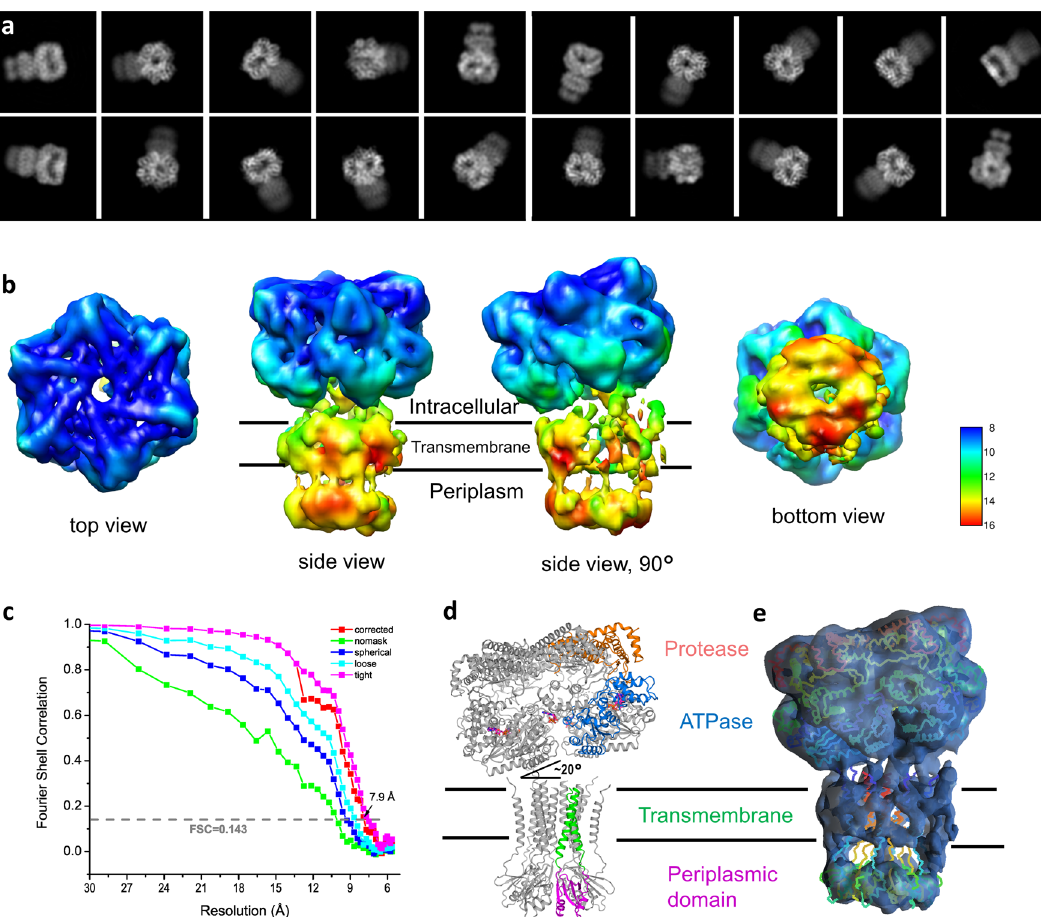
Fig. 6 Full-length Tm FtsH reconstruction at a low resolution. a Selected views of 2D class averages showing full-length Tm FtsH). b Four views of the reconstructed 3D map colored with local resolutions. c Gold-standard Fourier Shell Correlation. d A full-length Tm FtsH model with the transmembrane and periplasmic domains built by AlphaFold. e Fitting of the full-length Tm FtsH model into the density